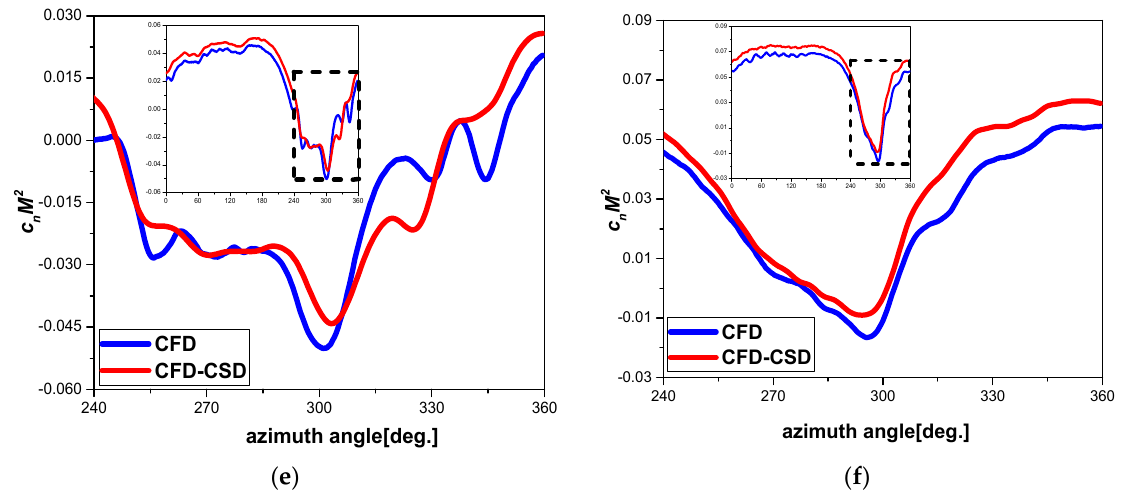
Figure 14. Comparison of the normal force in the last third of the period, obtained from the CFD and coupled CFD-CSD methods. ( a ) 1R Height r/R = 0.85. ( b ) Infinite height r/R = 0.85. ( c ) 1R Height r/R = 0.90. ( d ) Infinite height r/R = 0.90. ( e ) 1R Height r/R = 0.95. ( f ) Infinite height r/R = 0.95.